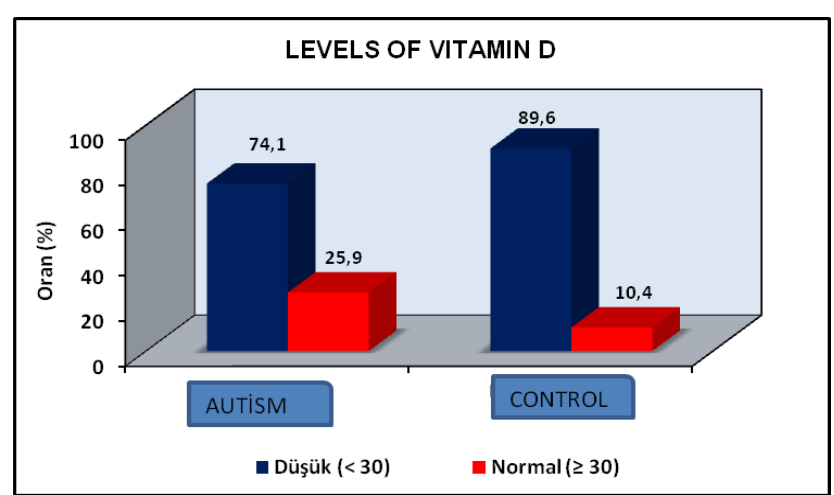
Figure 8. Distribution of Vitamin D Levels by